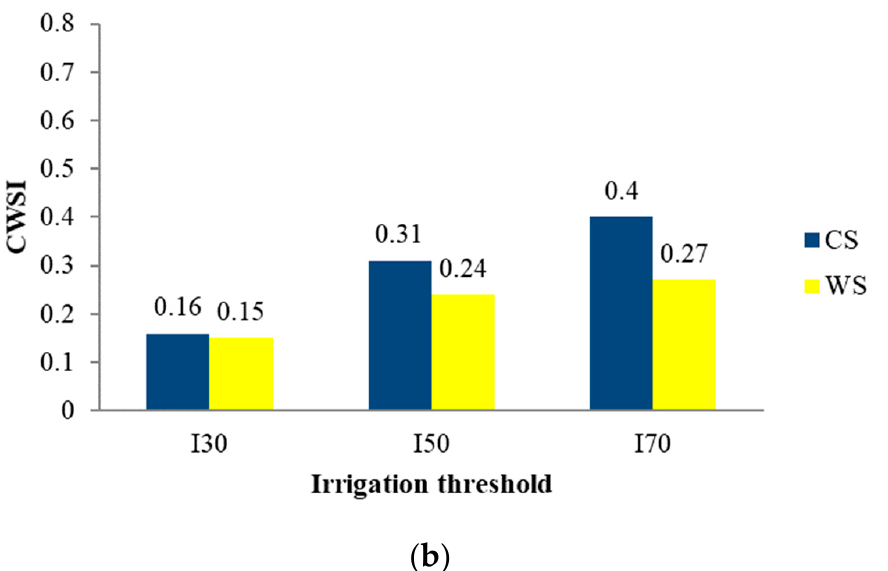
Figure 3. Average CWSI values just before irrigation ( a ) and for the whole season ( b ) of warm-season (WS) and cool-season (CS) turfgrass and different irrigation thresholds.